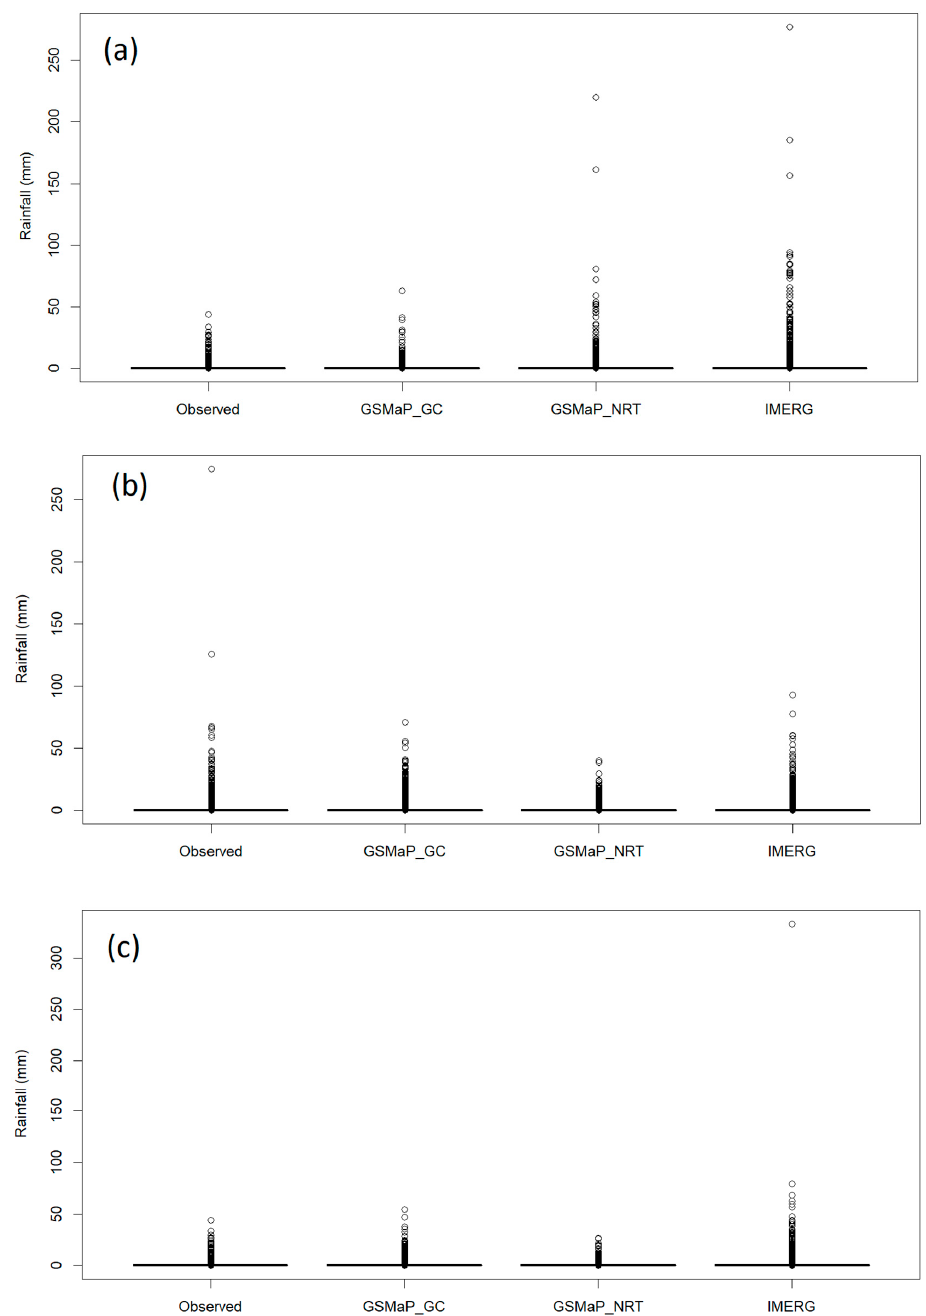
( c ) Figure 4. Box plot of in situ and satellite daily rainfall during 2000–2015 at ( a ) Baghdad, ( b ) Musol, ( c ) Basrah.